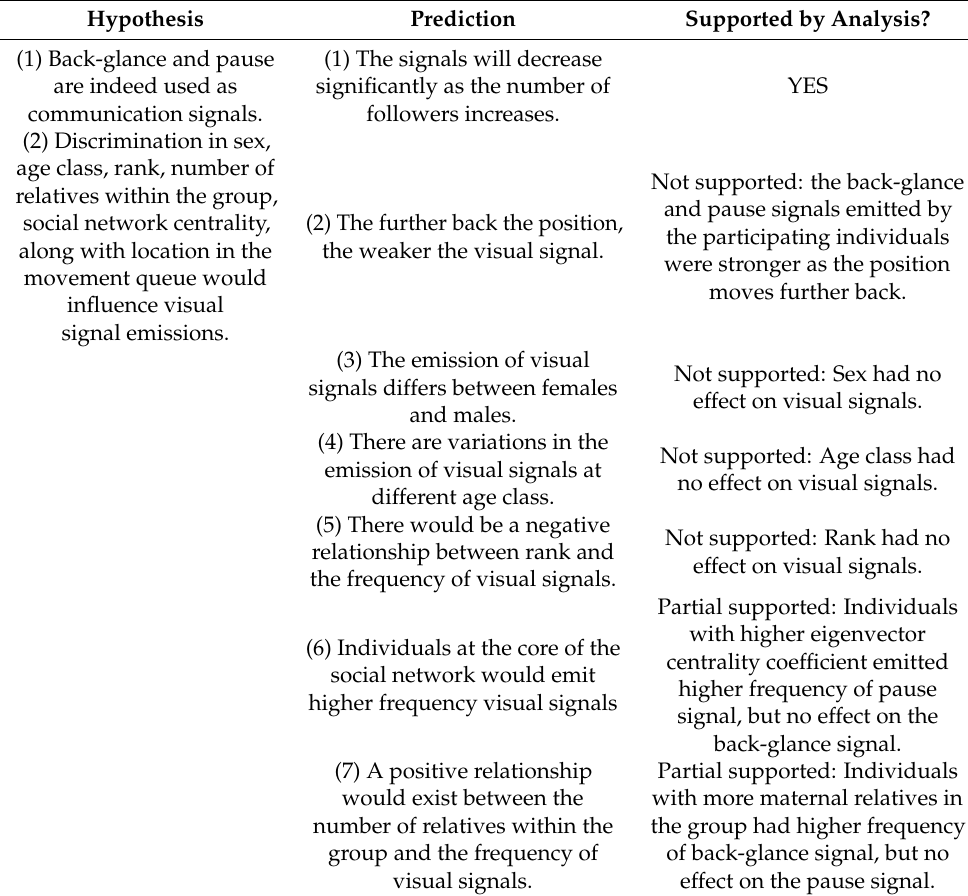
Table 2. Summary of analysis